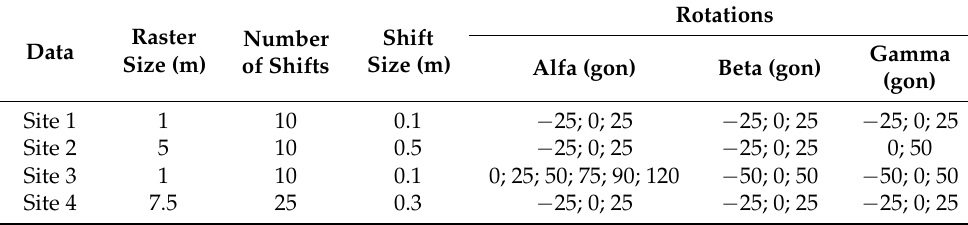
Table 1. Parameters of MDSR filter settings for individual